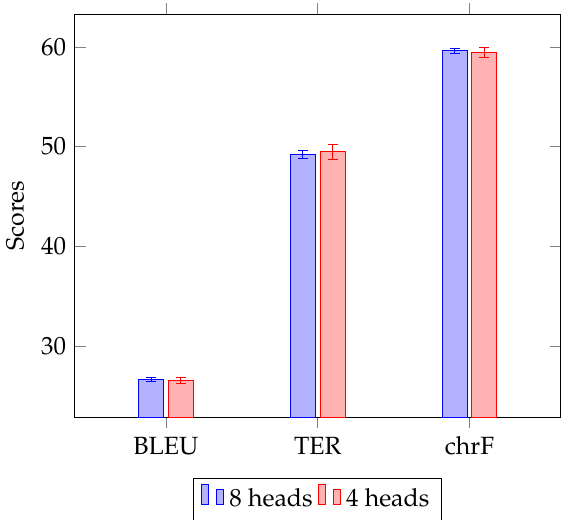
Figure 4. Average score comparison of student models with varying numbers of Transformer heads, including the standard deviations.